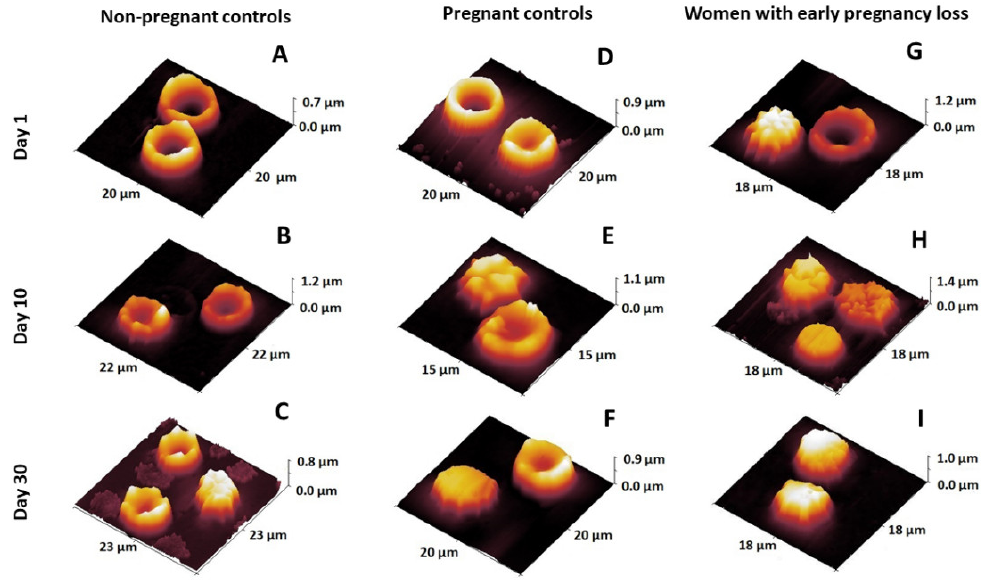
Figure 3. Selected 3D images of erythrocytes isolated from the studied groups of women ( A – I ) presenting morphological changes in the process of cell aging.